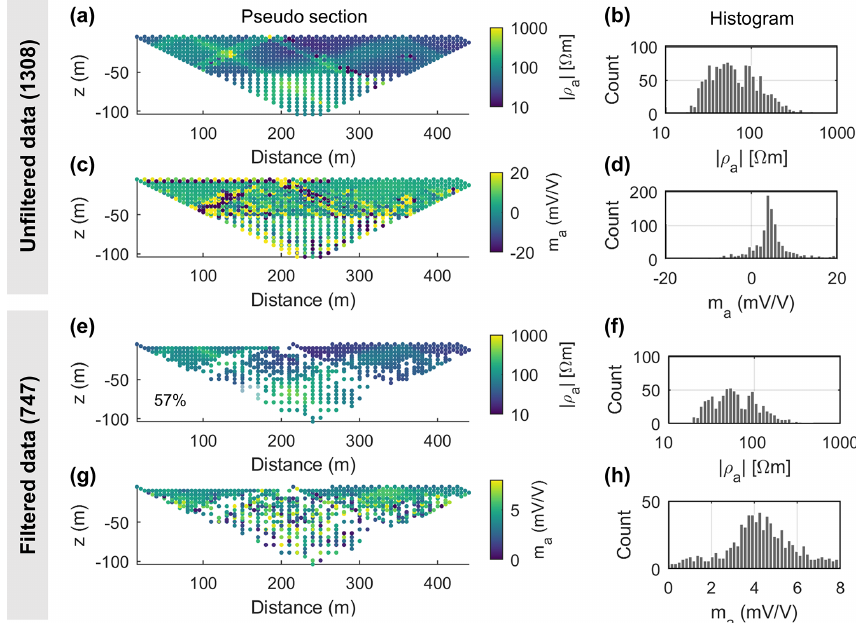
Figure A2. Apparent resistivity and apparent chargeability pseudo-sections (a, c, e, g) and histograms (b, d, f, h) of the TDIP measurement corresponding to the second part of roll-along Profile 1 of Lake Metzabok. The first two lines (a–d) show the unfiltered raw data set consisting of 1308 individual measurements; the last two lines (e–h) visualize the remaining 747 measurements after the application of the filters described in the main text.